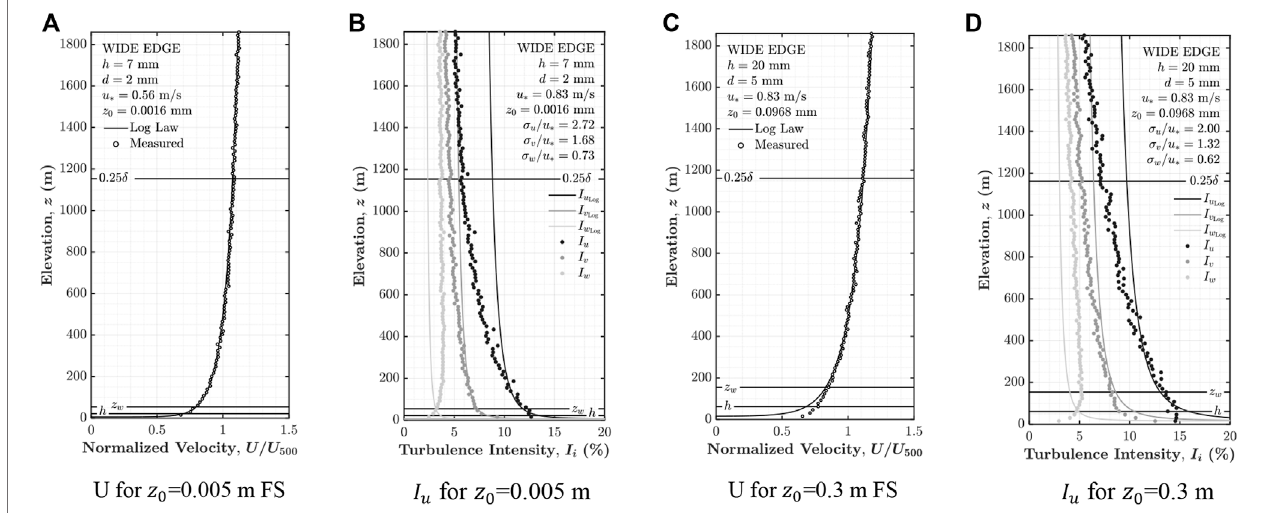
FIGURE 5 | Mean velocity and turbulence intensity pro fi les. (A) U for z 0 = 0.005 m FS, (B) I u for z 0 = 0.005 m, (C) U for z 0 = 0.3 m FS, and (D) I u for z 0 = 0.3 m.